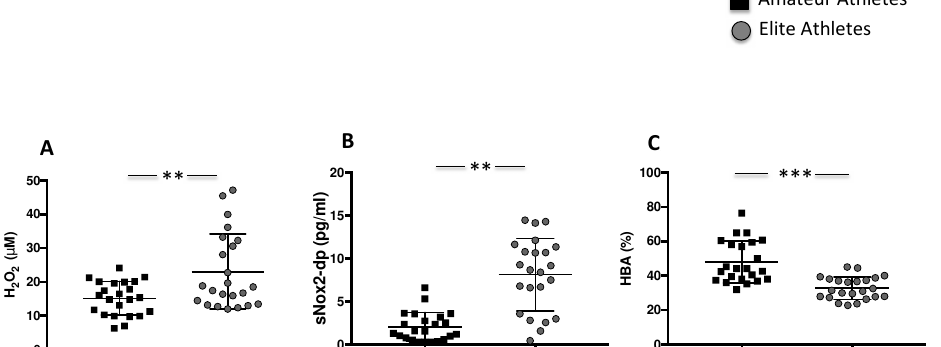
Figure 2. Oxidative stress in amateurs and elite football players. Serum levels of H 2 O 2 ( A ), sNOX2- dp ( B ) and % of HBA ( C ) in amateurs (n = 23) and in elite athletes (n = 23). (Data are represented as mean ± standard deviation) (*** p < 0.001; ** p < 0.01).